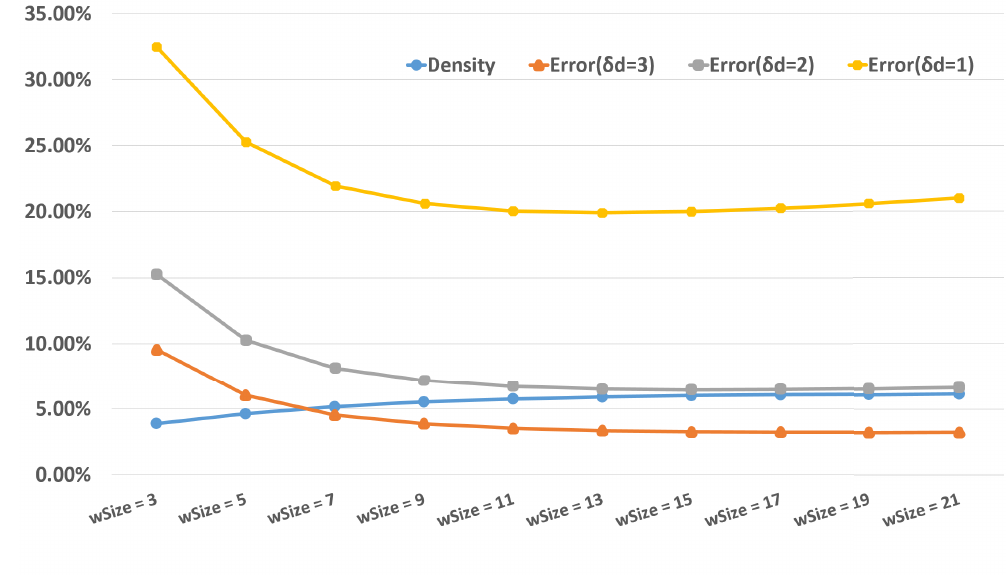
Figure 6. Effects of different window